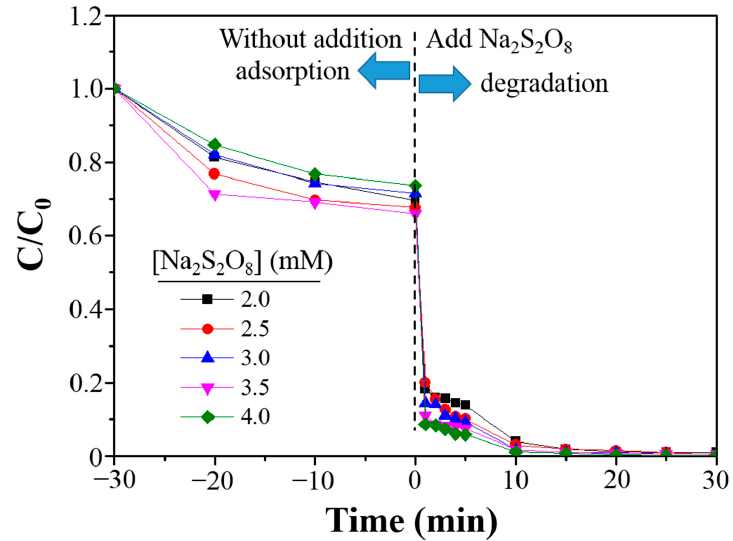
Figure 8. Fenton-like reaction for RhB degradation by H-CuFeS 2 samples at different concentration of Na 2 S 2 O 8 .